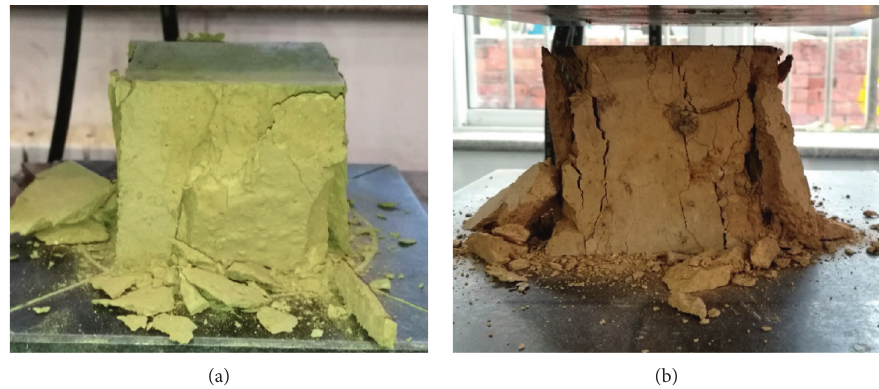
Figure 4: Failure modes of cube samples. (a) Molded adobe. (b) Rammed adobe. Table 6: Compressive strength measured directly on stacked half-blocks and cube samples. Sample Molded cube Compressed Loading